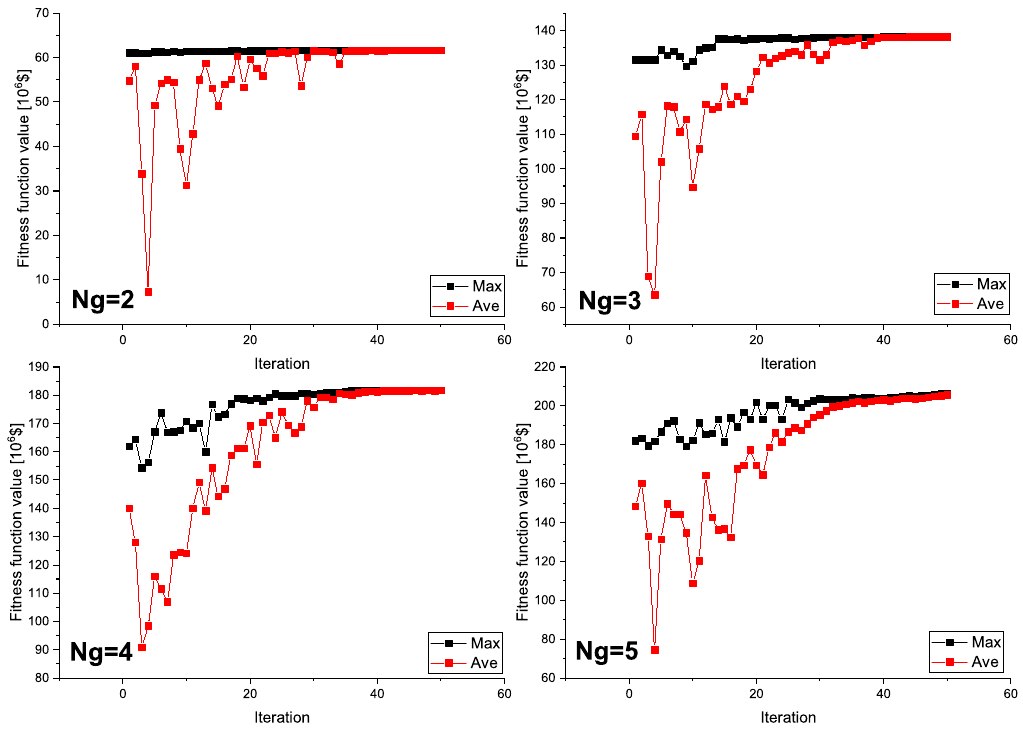
Figure 21. Changing the value of the objective function (maximum-max and averange-avg) during PSO